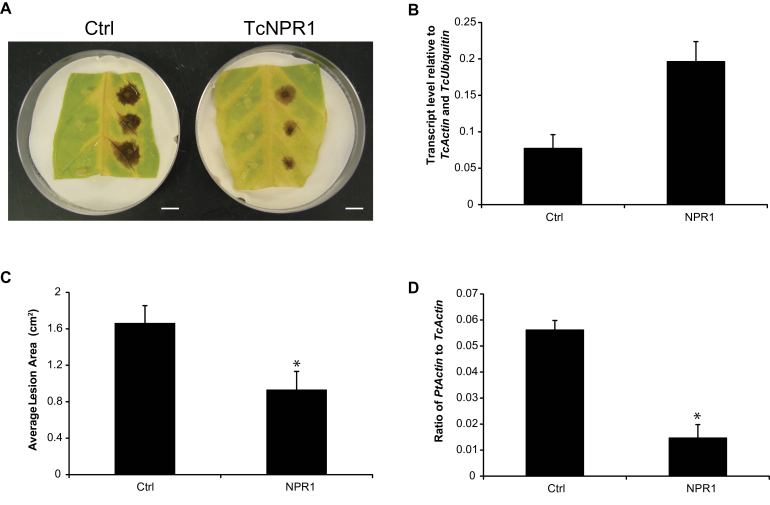
Functional analysis of TcNPR1. (A) Representative images of lesions from control and TcNPR1 transiently transformed leaves 2 d after Phytophthora tropicalis inoculation. (B) qRT-PCR analysis of TcNPR1 transcript 2 d after vacuum infiltration. Ctrl, control; NPR1, TcNPR1overexpression. Bars represent means ±SE of three biological replicates. (C) Average lesion areas from control and TcNPR1 overexpressing leaves were measured 3 d after inoculation using ImageJ. Bars represent the means ±SE of measurements from 12 lesion spots from four leaf discs of each genotype. The asterisk denotes a significant difference determined by single factor ANOVA (P<0.05). (D) Pathogen biomass was measured at the lesion sites by qPCR to determine the ratio of pathogen DNA to cacao DNA 2 d after inoculation. Bars represent four biological replicates, each with three technical replicates. The asterisk denotes a significant difference determined by single factor ANOVA analysis (P<0.05).